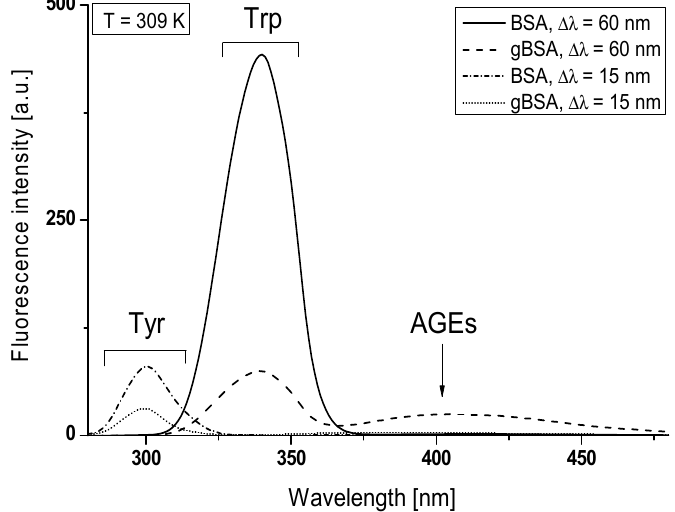
Figure 1. Synchronous fluorescence spectra of non-glycated (BSA: — Δλ = 60 nm, - ∙ - ∙ - ∙ Δλ = 15 nm) and glycated (gBSA: --- Δλ = 60 nm, ∙∙∙ Δλ = 15 nm) bovine serum albumin, BSA, gBSA = 5 × 10 − 6 mol ∙ L − 1 , T = 309 K.